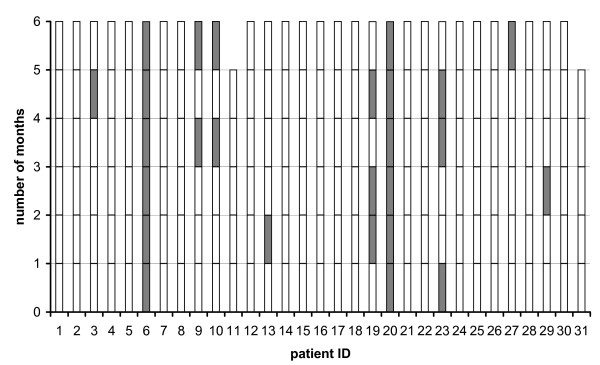
Intraindividual daily compliance during the observation period. Compliant months (daily compliance ≥ 80%, white bars) or non-compliant months (daily compliance < 80%, grey bars); patient #11 and patient #31 participated five months only.